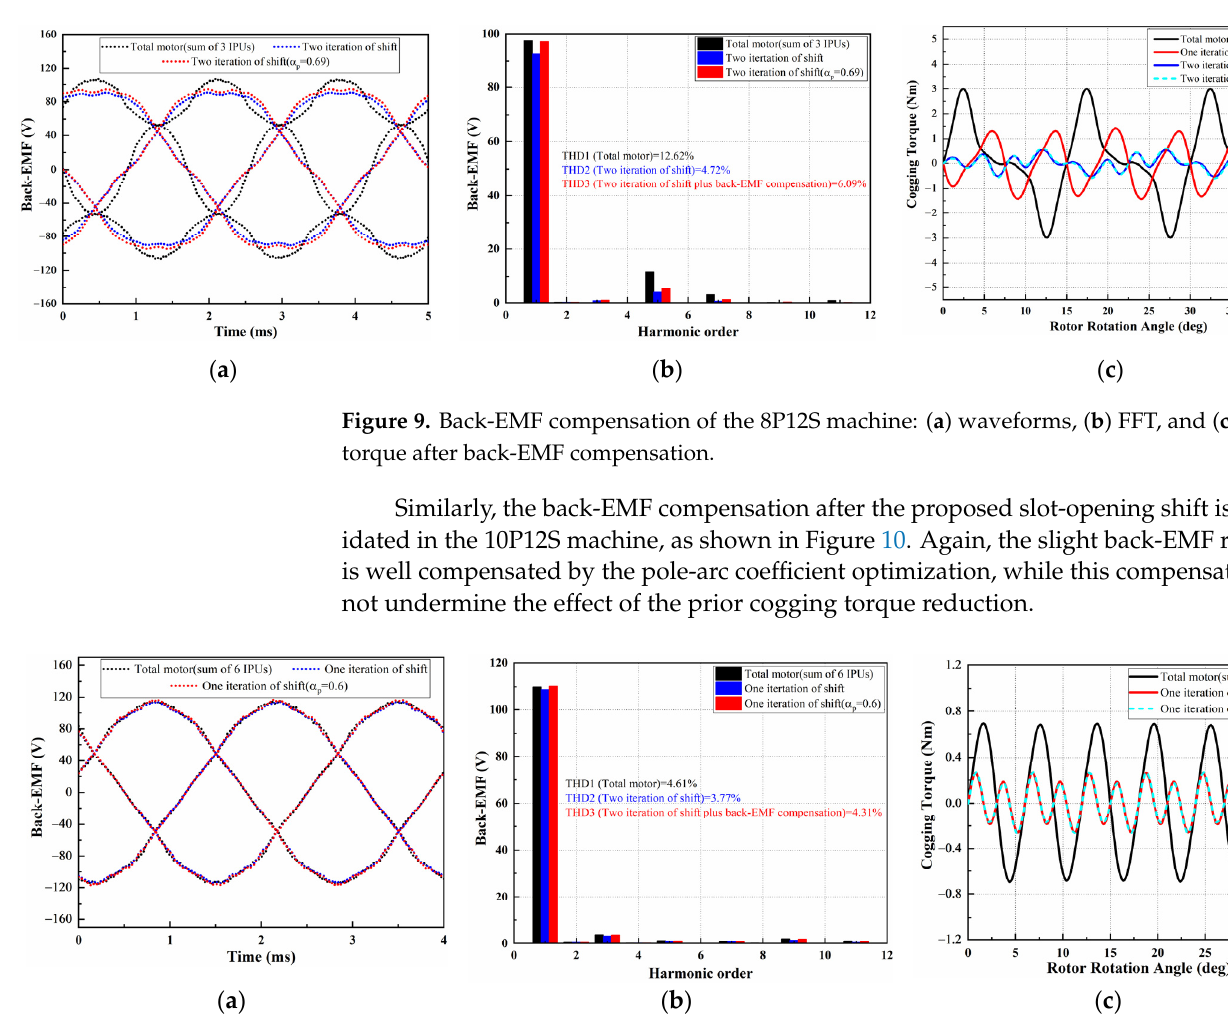
( b ) Figure 7. The cogging torque FEA pattern with FFT results: ( a ) the IPU1 and ( b ) the total motor. For the 10P12S machine ( λ= / 2 =6 c N p , η λ= / =2 s N ), the desired shift angle can be also be determined, and the values are shown in Error! Reference source not found. . Ac- cording to Error! Reference source not found. , the desired shift angle is θ π= ⋅ ⋅ =  shift_6 / (5 6 2)